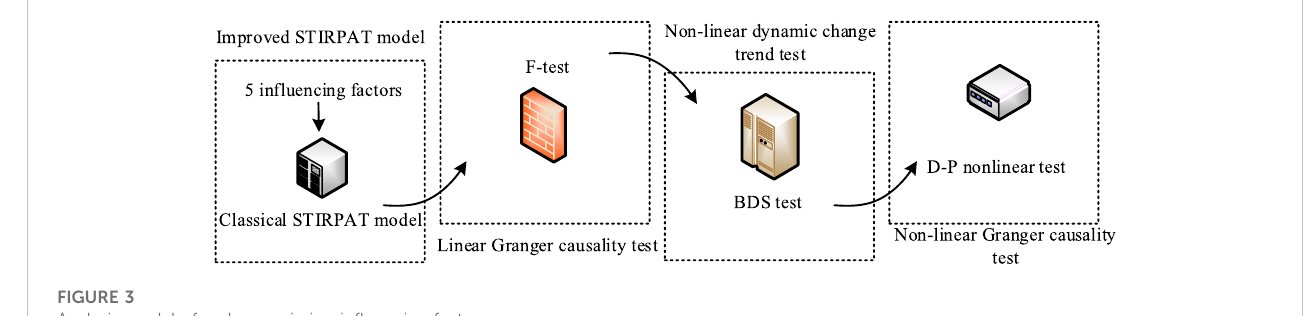
FIGURE 3 Analysis model of carbon emission in fl uencing